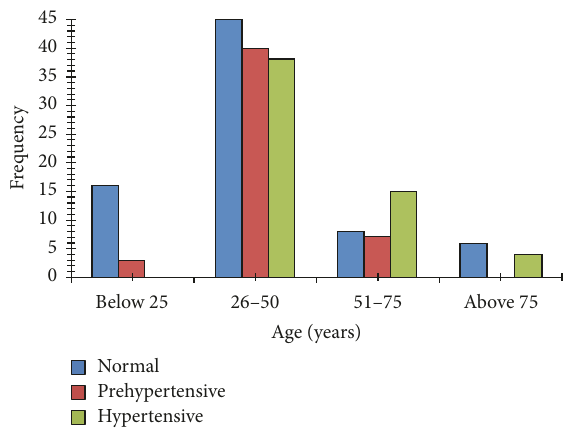
Figure 1: Prevalence of prehypertension and hypertension based on age in the study cohort. Prehypertension was defined as SBP 120–139 mmHg or DBP 80–90mmHg and hypertension as SBP ≥ 140mmHg or DBP ≥ 90